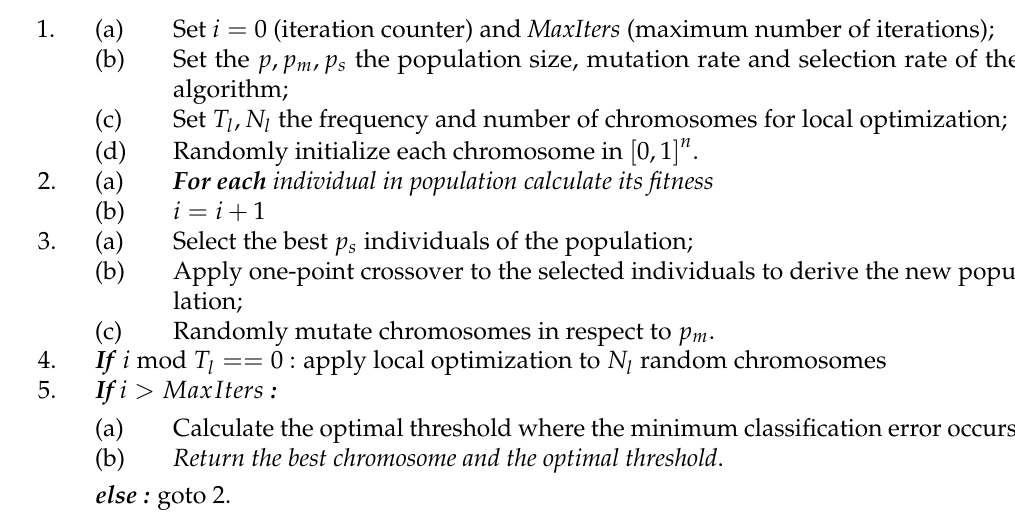
Algorithm 1 Training Elman-Classifiers